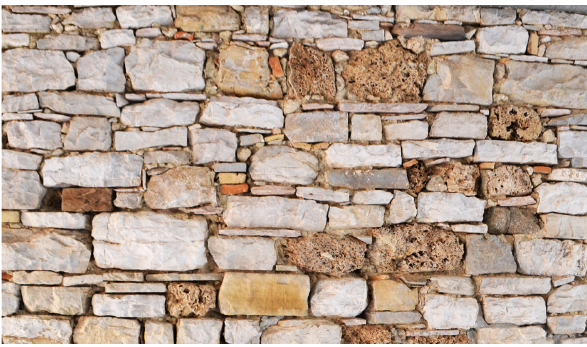
Figure 4. Frosolone (Isernia, Italy): the photo shows a masonry of limestone and cimenti (Romano, 2016).